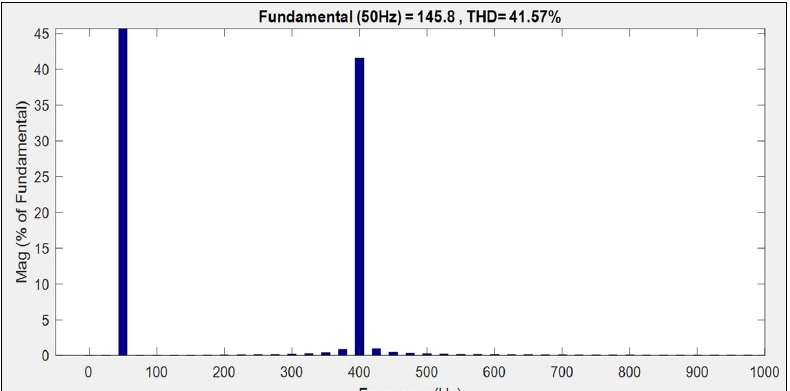
Figure 12. The THD case study 1 performance results with NRIT.